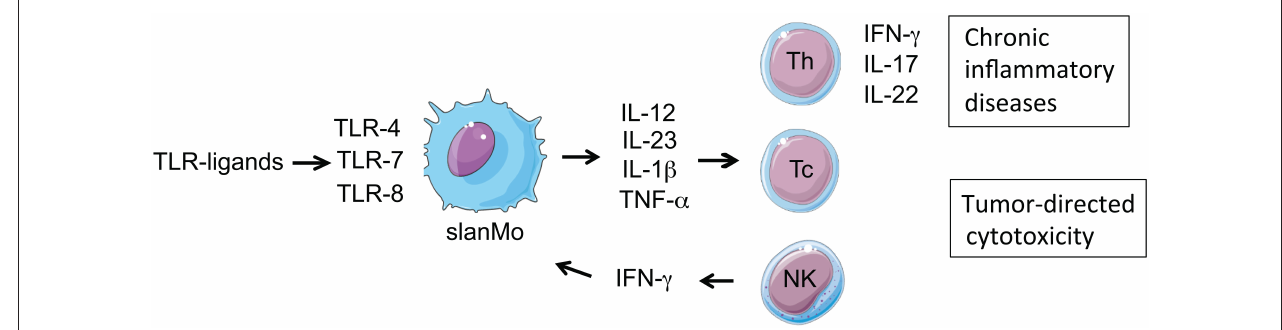
FIGURE 1 | Immune regulatory function of slanMo: slanMo are activated via TLR stimulation to produce pro-inflammatory cytokines, thereby programming and enhancing Th1 and Th17T cell responses, which play a major role in chronic inflammatory diseases. Activated slanMo also promote cytotoxic CD8 and NK